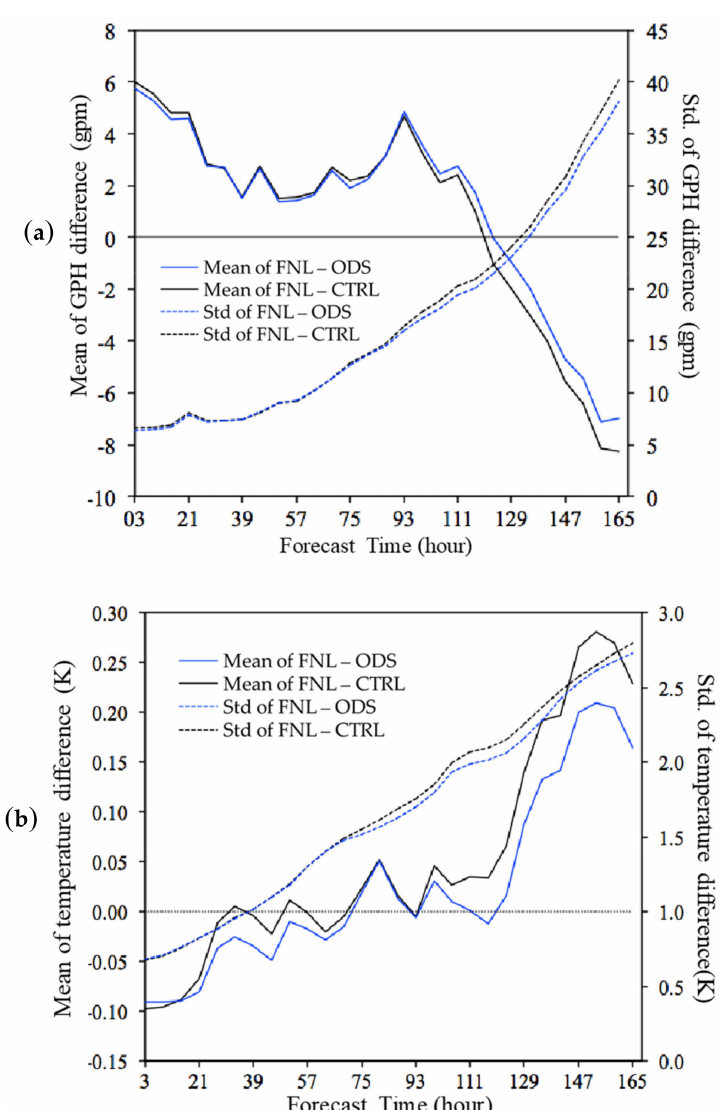
Figure 8. Mean (solid lines) and standard deviation (dashed lines) of the di ff erences of ( a ) geopotential height at 500 hPa and ( b ) atmospheric temperature at 300 hPa between the ODS / CTRL forecasts and the FNL forecasts (FNL–ODS, blue lines; FNL − CTRL, black lines) varying with the forecast time in the region (20–60 ◦ N, 0–360 ◦